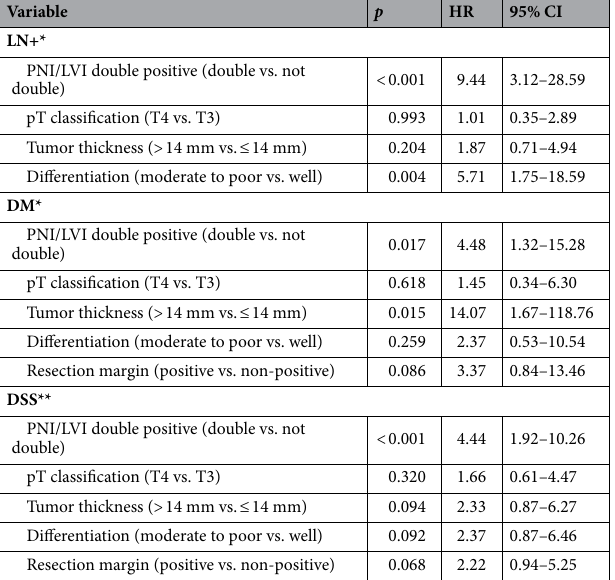
Table 4. Multivariate analyses of independent predictors of primary OSCC for LN+, DM and DSS (PNI and LVI combined). OSCC oral squamous cell carcinoma, PNI perineural invasion, LVI lymphovascular invasion, LN + neck metastasis, DM distant metastasis, DSS disease-specific survival. *Binary logistic regression. **Cox proportional hazards model.